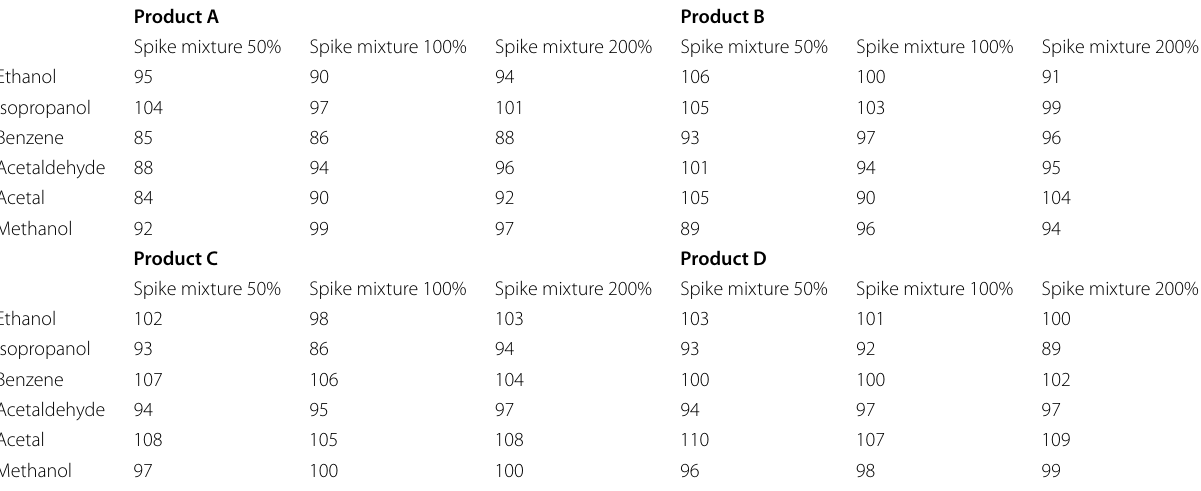
Table 5 Validation of spike recovery assay for active ingredients and level 1 impurities using concentrations at 50%, 100%, and 200% of the temporary guidance